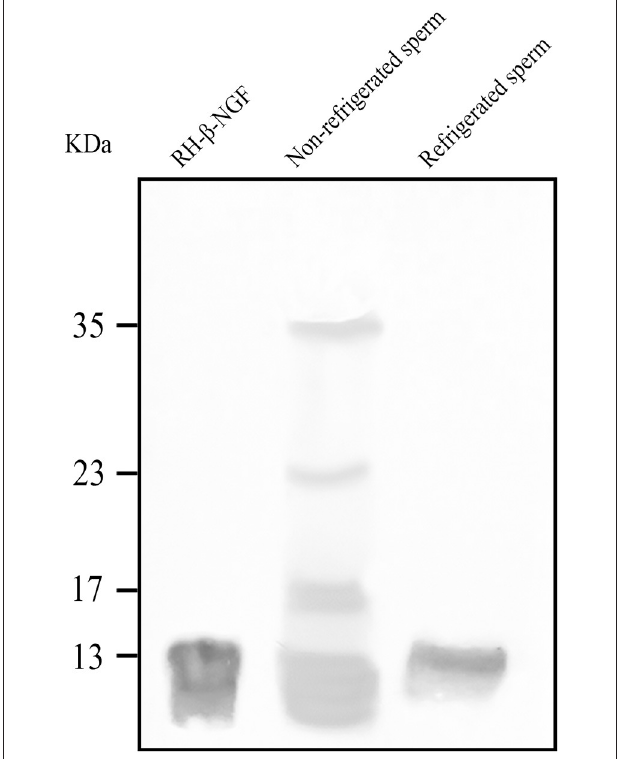
FIGURE 1 | Western blotting of β -NGF protein in llama sperm-adsorbed protein (SAP) of both, fresh and 24h refrigerated spermatozoa. At positive control, 100 ng of recombinant human β -NGF (RH- β -NGF) was run.